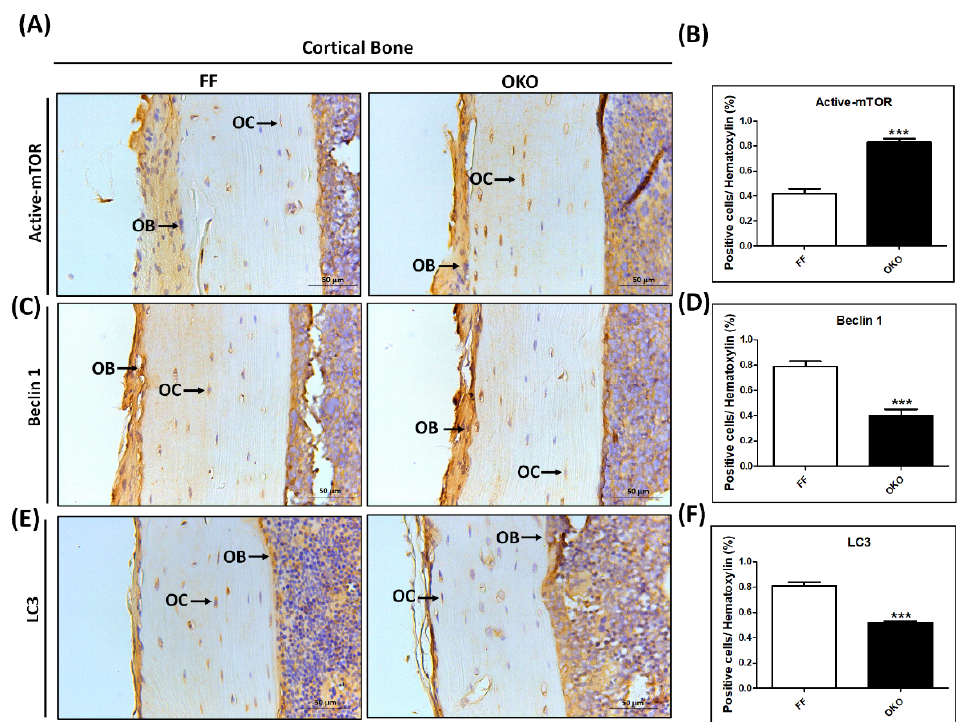
Figure 6. DDR1 knockout significantly decreased autophagy-related protein levels in OKO mice. ( A ) The representative IHC of the phosphorylation of the mechanistic target of rapamycin (phospho-mTOR) in FF and OKO mice. ( B ) Quantitative analysis of the IHC staining of phospho-mTOR. ( C ) The representative IHC of beclin-1. ( D ) Quantitative analysis of IHC of beclin-1. ( E ) The representative IHC of light chain 3 (LC3). ( F ) Quantitative analysis of IHC of LC3. The positive immunolocalizations are stained dark brown. A black arrow indicates positive cells (OB + OC); OB: osteoblasts, OC: osteocytes. Magnifications of 400× are shown, with scale bars of 50 μ m. Each bar represents the mean ± SE of six samples in each group (*** p < 0.001 versus FF mice).